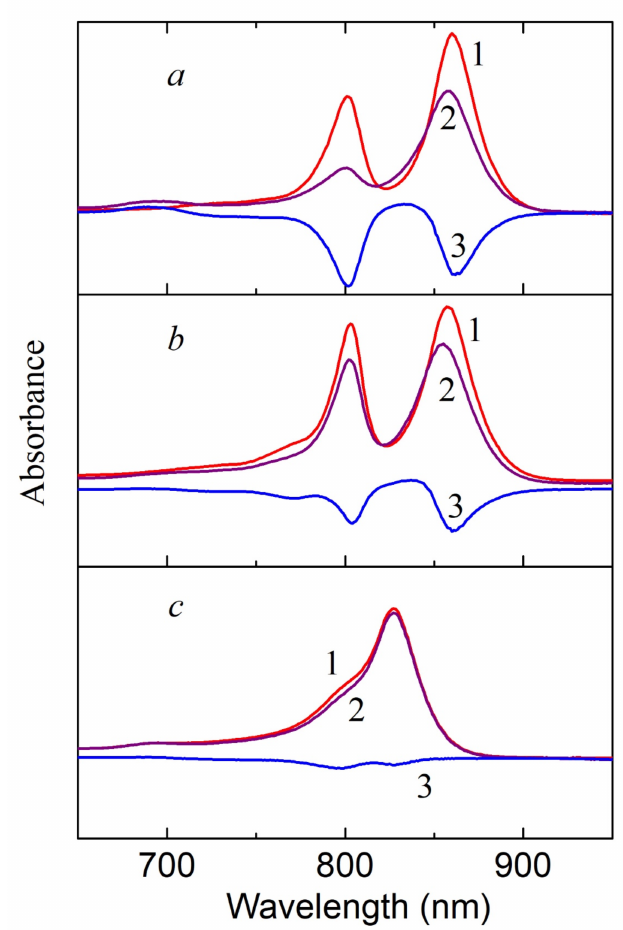
Figure 3. Absorption spectra of LH2 complexes from Rbl . acidophilus ( a ), Rps . palustris ( b ), and Mch. purpuratum ( c ) before (1) and after (2) 30 min illumination in the presence of 50 µ M RB. Differential absorption spectrum “30 min illumination in the presence of 50 µ M RB minus 0 min”